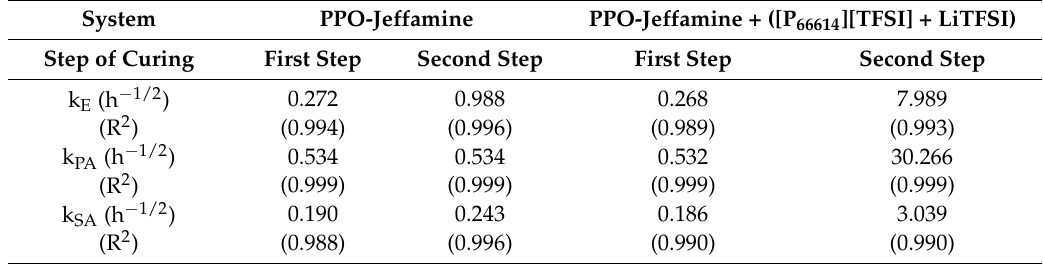
Figure 4. Epoxy conversion (E), and primary amine (PA) and evolution of secondary amine (SA) during the reaction time at 110 °C for 6 h and at 120 °C for 6 h of ( a ) neat PPO-Jeffamine networks compared to ( b ) PPO-Jeffamine/Electrolyte system with 50 wt % of ([P66614][TFSI] + 0.75 M LiTFSI). Table 6. The kinetic constants (h − 1/2 ) of reaction for epoxy functions (k E ), for primary amine functions (k PA ) and for secondary amine functions (k SA ) and correlation